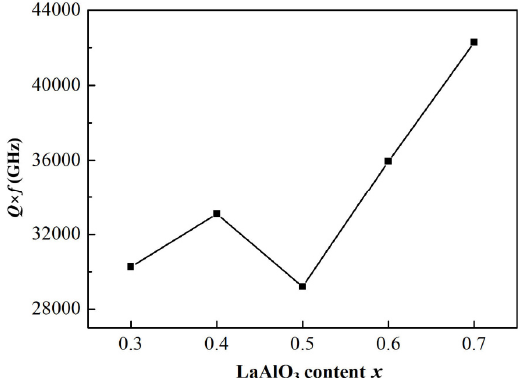
Fig. 5 Q × f values of the CTLA ceramics sintered at 1450 ℃ for 4